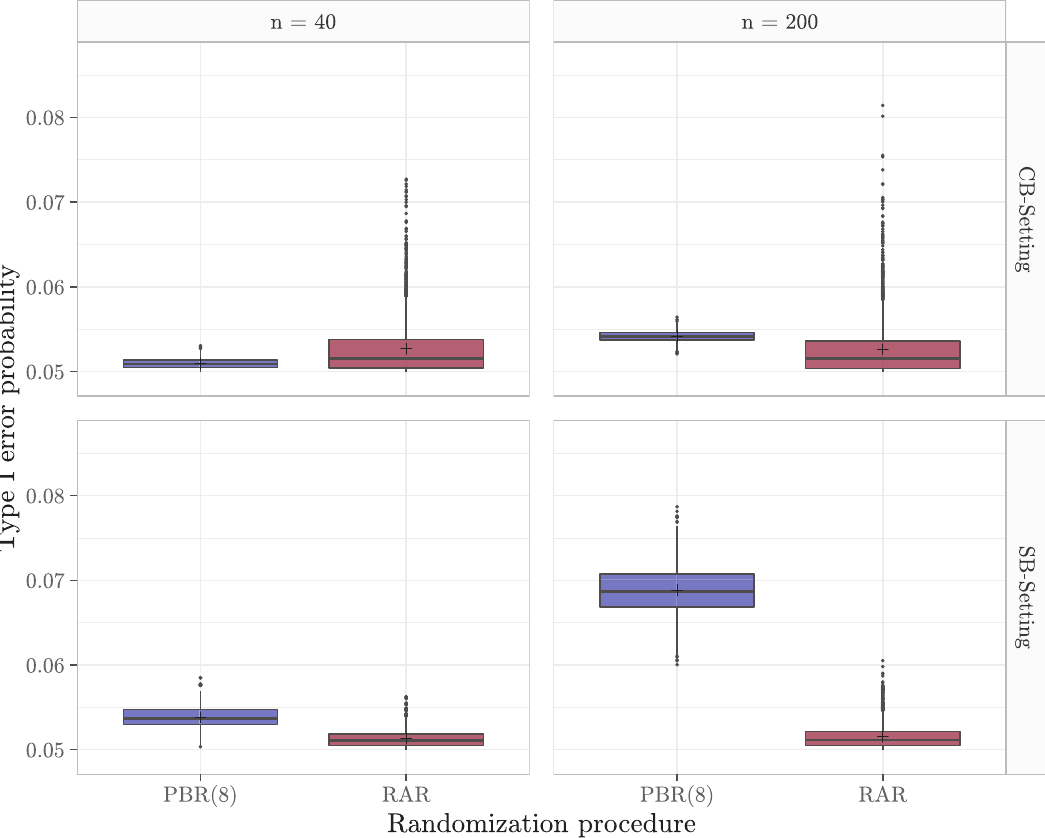
Fig 1. Influence of the study setting on the distribution of type I error probabilities. The distributions are based on a sample of 2,500 randomization sequences per randomization procedure.